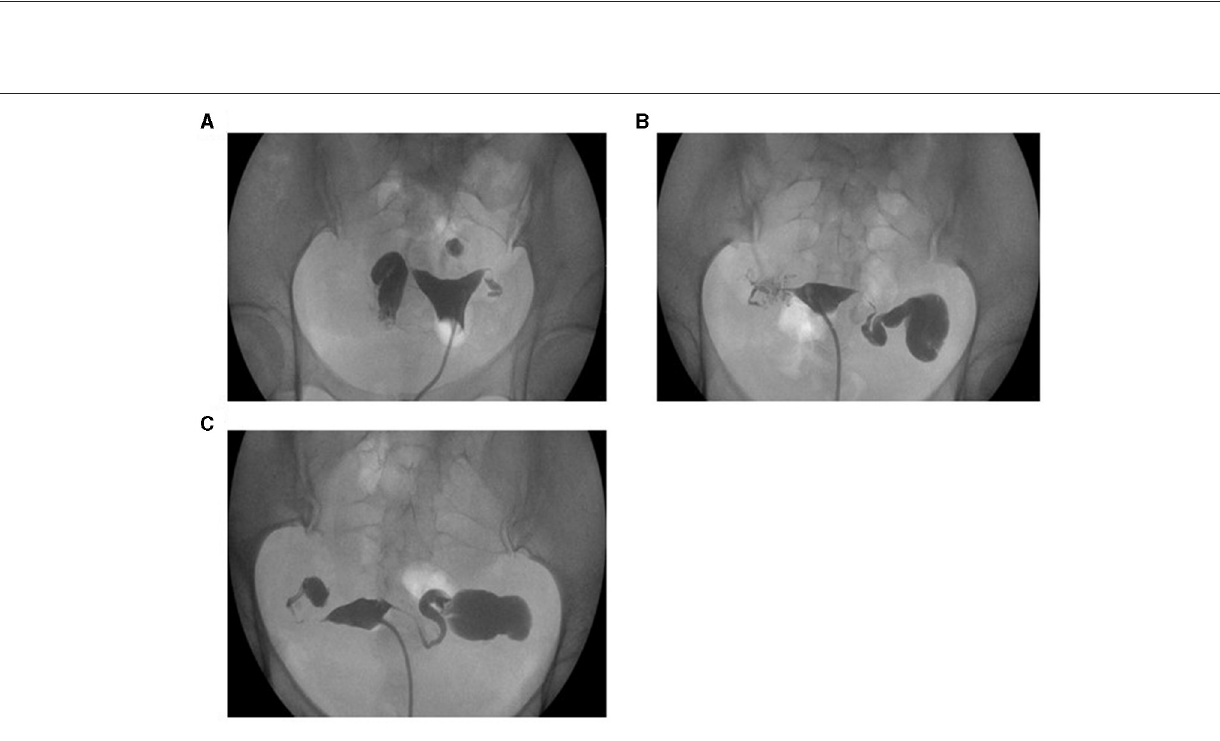
Frontiers in Medicine |